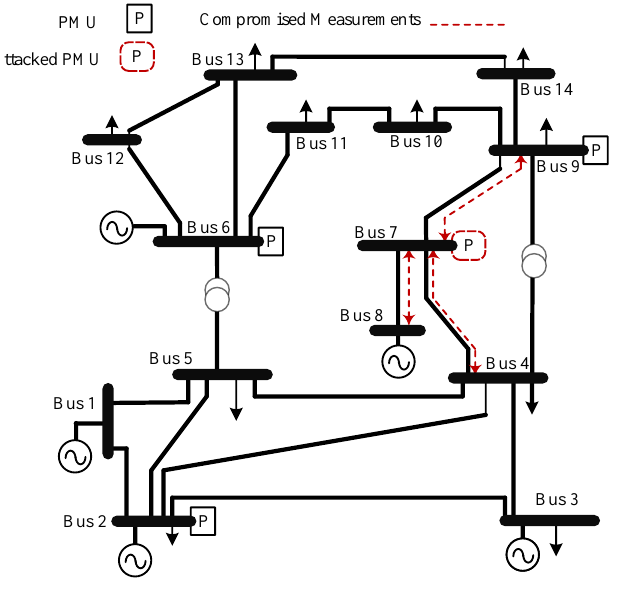
Figure 6. IEEE 14-bus with PMU